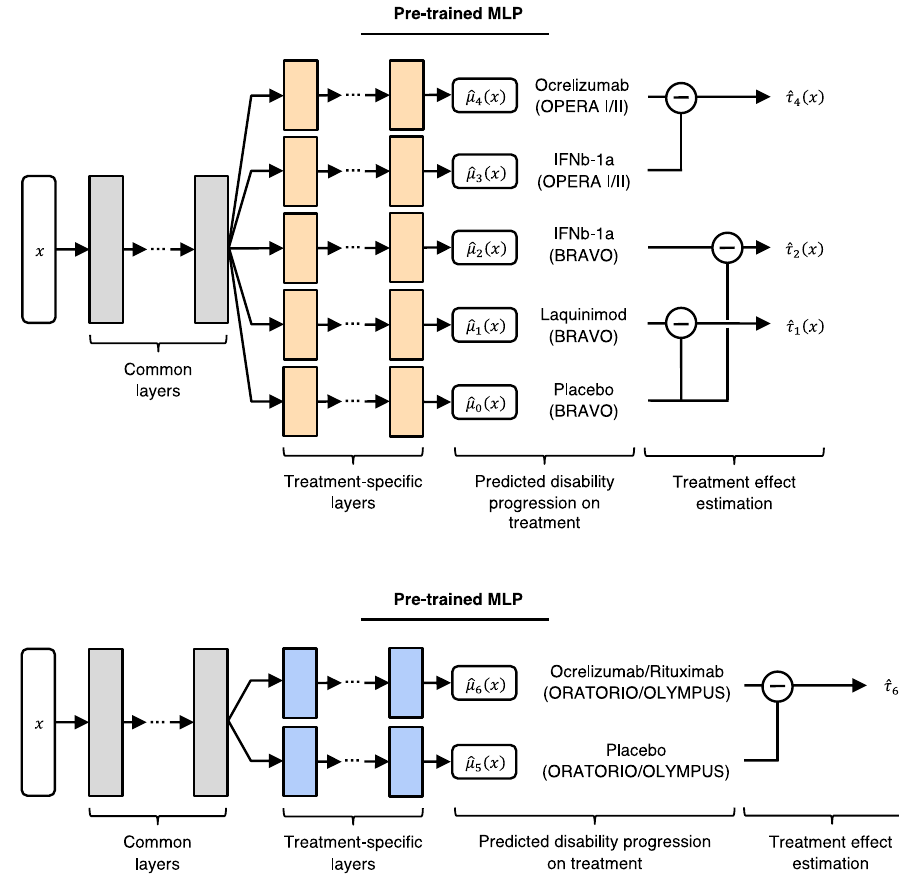
Fig. 3 | Multi-headed multilayer perceptron (MLP) architecture for CATE esti- mation. The MLP was fi rst pre-trained on a relapsing-remitting multiple sclerosis dataset (top), followed by fi ne tuning on a primary progressive multiple sclerosis dataset (bottom). Subtraction symbols indicate which treatment and control are being subtracted for the CATE estimate. Gray-colored layers indicate the common